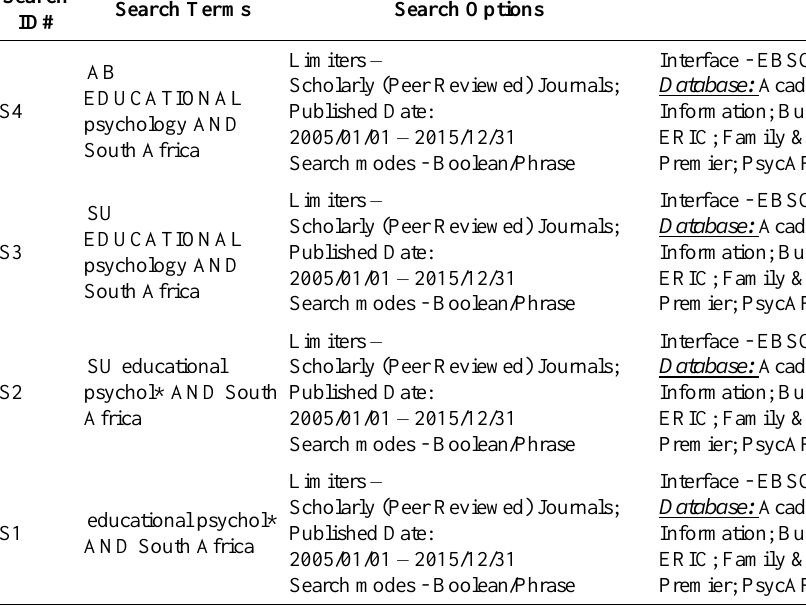
Results from the first advanced search on ‘Educational Psychology’ and ‘South Africa’ during the period 2005 –